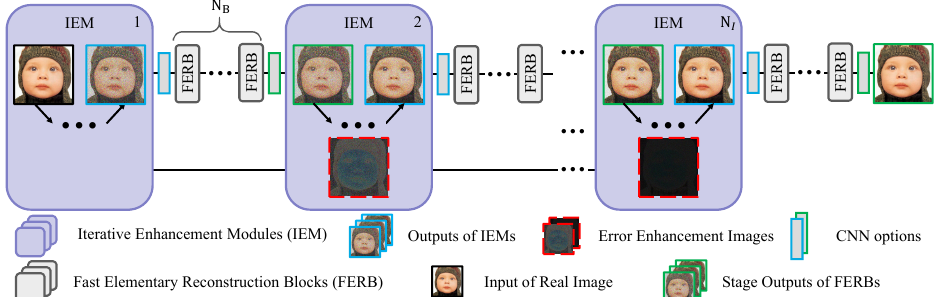
Figure 1. The overview of the proposed method. The real image input X is marked by a solid black wireframe. The error enhancement images EEI and initial reconstruction images IRI represent the intermediate variables and the outputs of N I Iterative Enhancement Modules (IEMs, introduced in Section 3.2), which are marked as blue solid and red dashed boxes, respectively. Each iterative recovery contains N B Fast Elementary Reconstruction Blocks (FERBs, introduced in Section 3.1) to accomplish the nonlinear problem solution of image restoration. The outputs of the FERBs are marked with green boxes. Two kinds of CNN blocks marked by blue and green represent two kinds of one-layer CNN. They are employed to adjust the I/O channels to adapt to the FERBs and